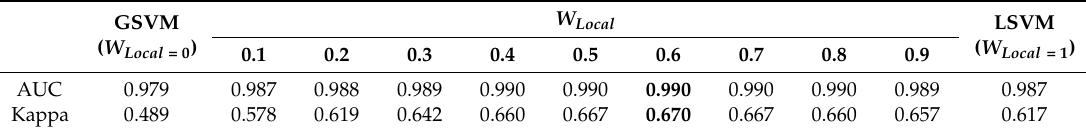
Table 3. Relationship between W Local , the AUC and the kappa coefficient.